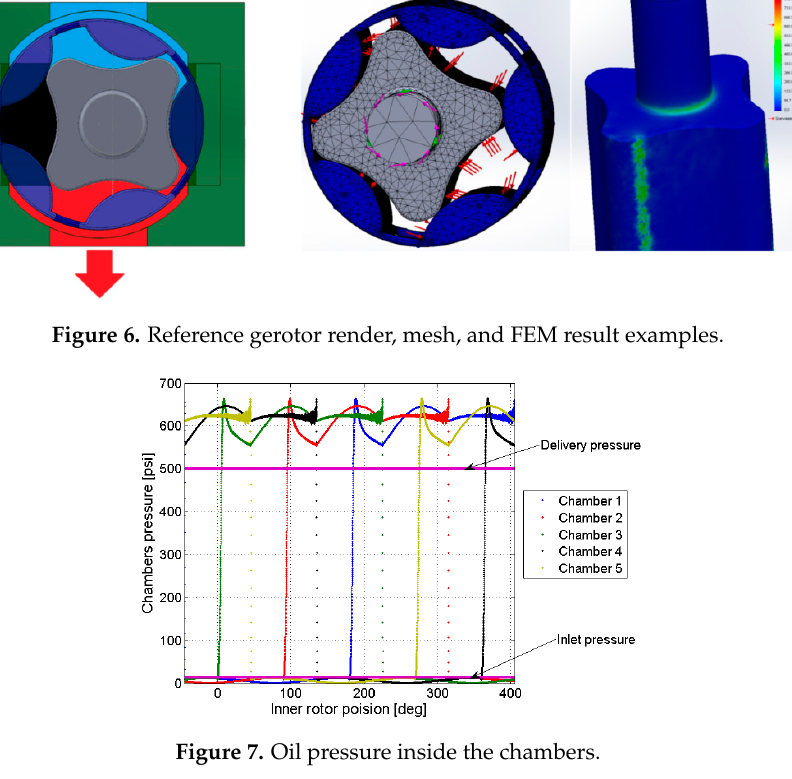
Figure 8. Resistant torque.